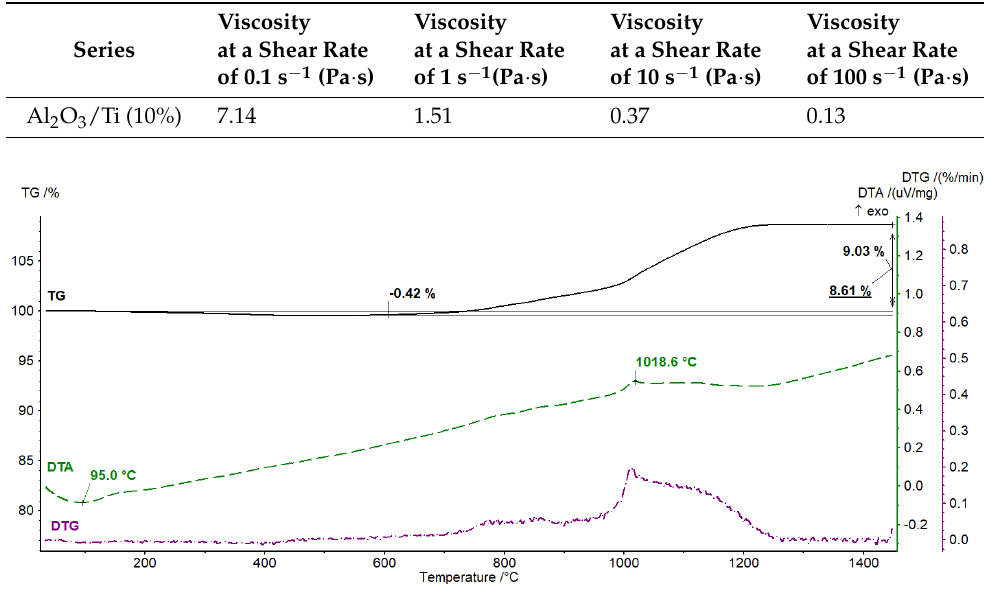
Table 3. Value of dynamic viscosity of prepared ceramic slurries for shear rates of 0.1; 1; 10; and 100 s − 1 .